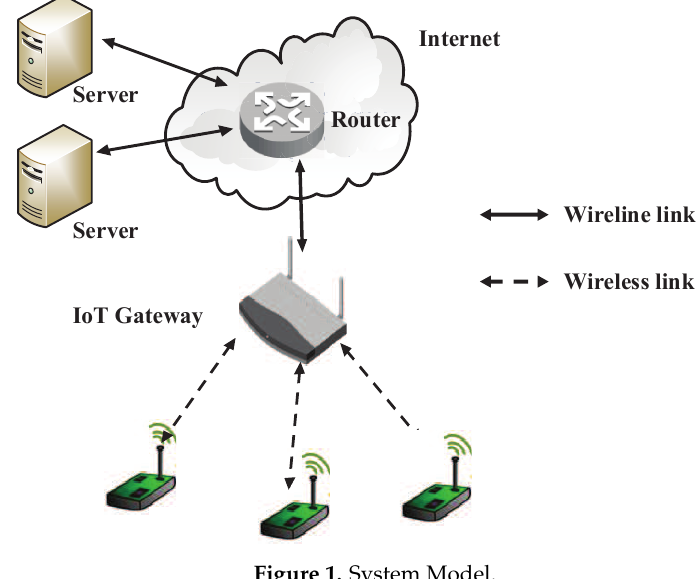
Figure 1. System